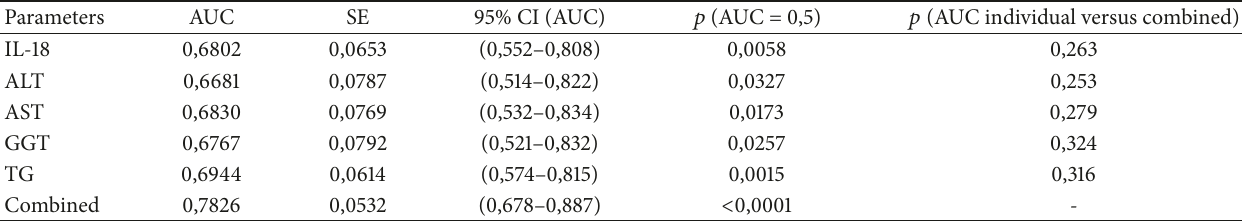
Table 5: Analysis of AUC for IL-18, ALT, AST, GGT, and TG and their combination to detect children with liver steatosis in 1 HMRS.